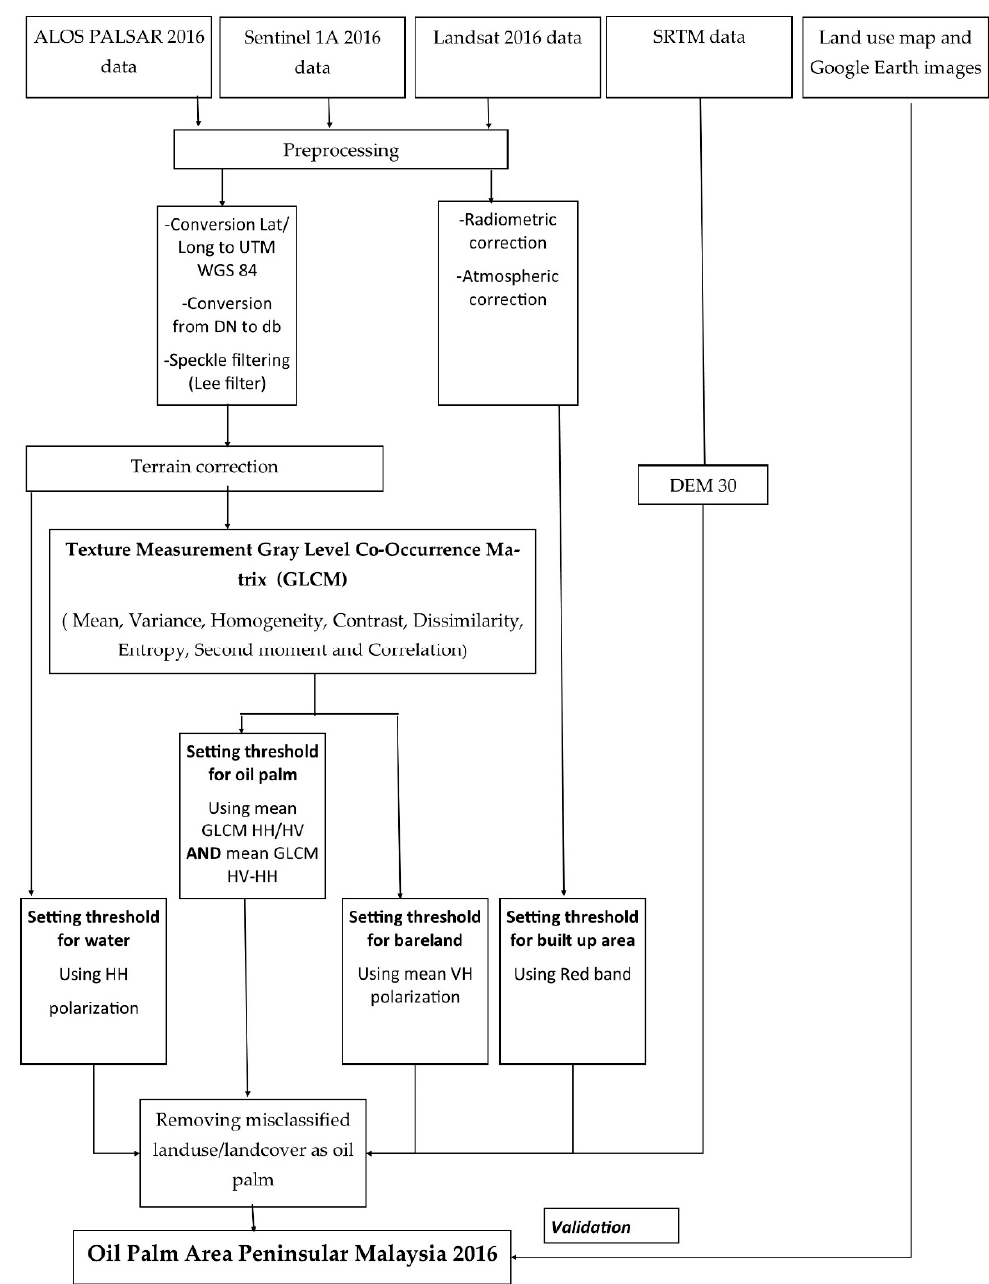
Figure 2. Methodology used to detect oil palm plantation in Peninsular Malaysia.